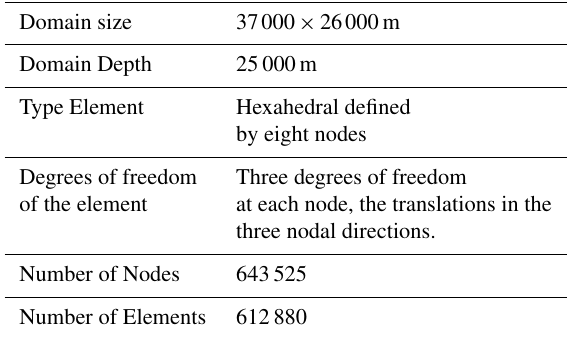
Table 1. Main characteristics of the